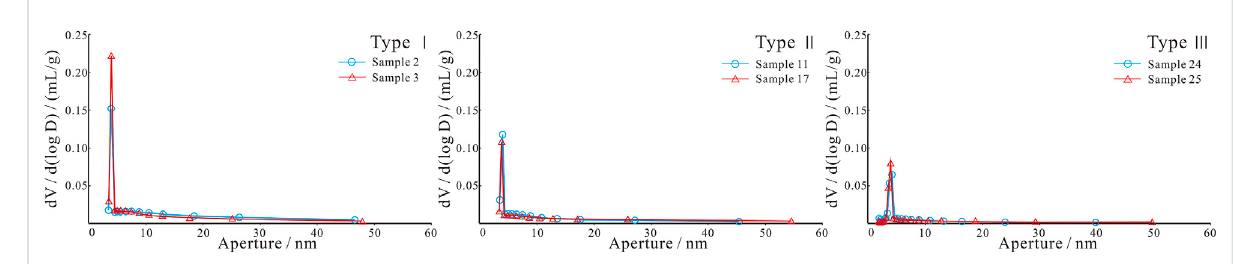
FIGURE 9 Aperture distribution curve based on the low-temperature N 2 adsorption experiments.